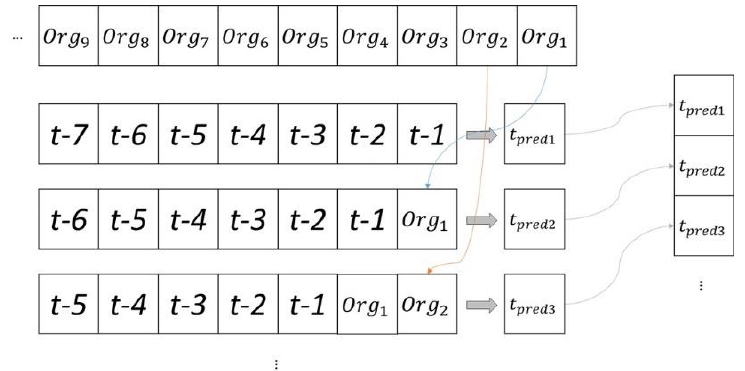
Figure 4. Proposal of the phased and replacement model to avoid prediction over prediction.